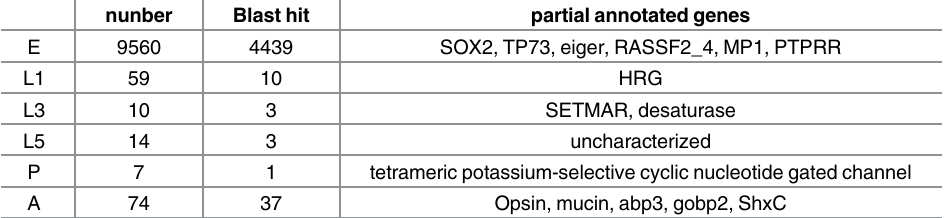
E, L1, L3, L5, L, P, and A refer to egg, fi rst stage of larva, third stage of larva, fi fth stage of larva, pupa, and adults of P . pieris , respectively.Abp3: antennal binding protein 3; gobp2: general odorant-binding protein 2, uncharacterized, Hrg: histidine-rich glycoprotein, TPSCNGC, tetrameric potassium-selective cyclic nucleotide gated